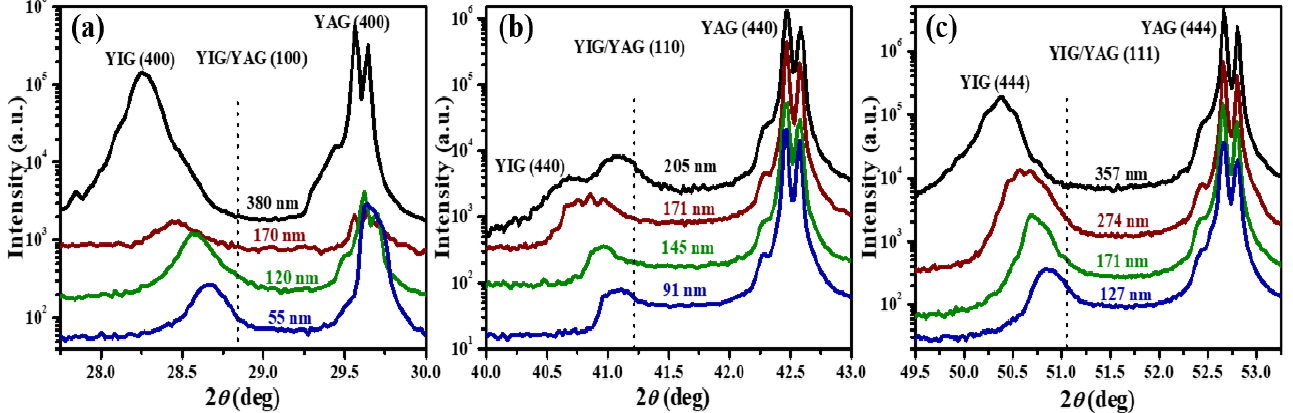
Figure 3. ( a ) XRD patterns for the YIG film on ( a ) (100), ( b ) (110), and ( c ) (111) YAG substrates. The positions of the dotted lines in the figure represent the diffraction peaks of the corresponding orientation of bulk YIG. Table 1. Thickness of YIG films on (100), (110), and (111) YAG as a function of deposition time.